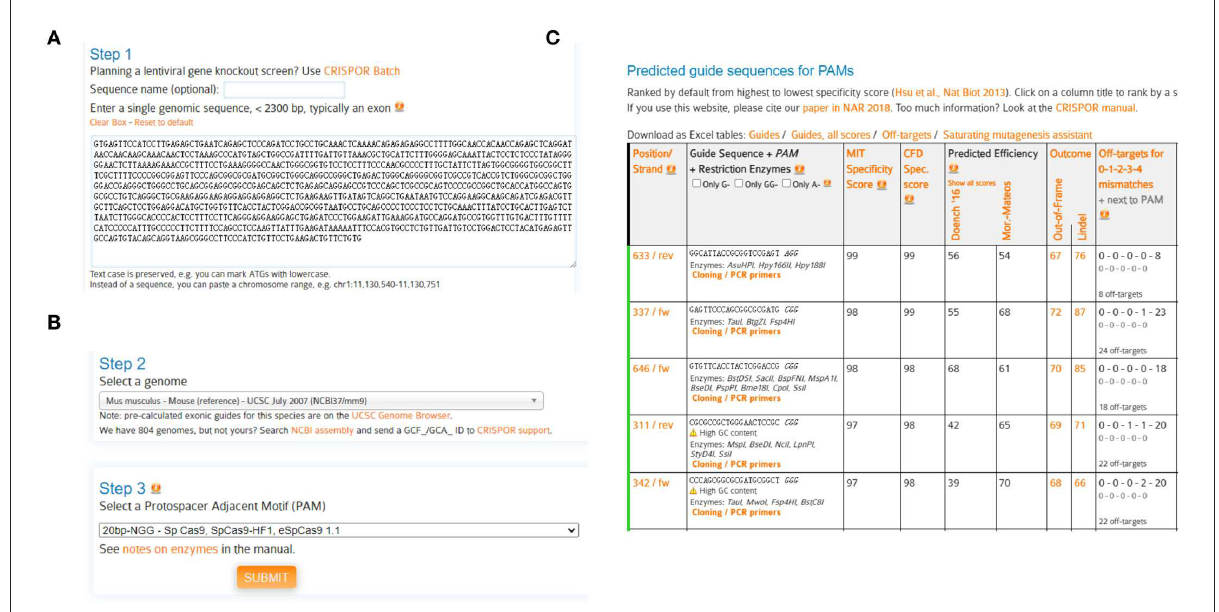
FIGURE1 Schematic diagram of sgRNA design. (A) Query genomic DNA sequence (containing 5’UTR, exon1, exon2) of LRRK2 with the webserver CRISPOR. (B) Select a genome [Mus musculus-Mouse (reference)-UCSC July 2007 (NCBI37/MM9)] and a protospacer adjacent motif (PAM) (20bp-NGG-Sp Cas9, SpCas9-HF1, eSpCas9 1.1). (C) Output of predicted guide sequences by CRISPOR. Rank and select sgRNAs with high specificities and efficiencies.